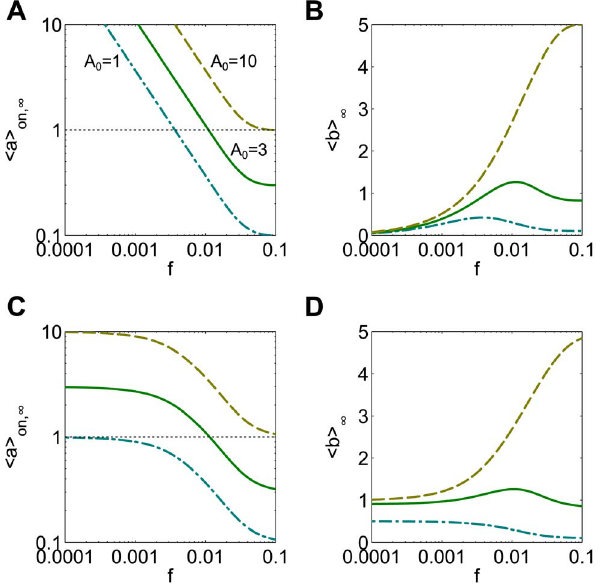
Figure 8. Input signal dose can affect whether a bell-shaped response is observed. The production rate function is F(a)=a 2 / (a 2 + K 2 ) with K=1. ( A ) Amplitude compensated signals with A 0 =10 (tan dashed curve) leads to , a . on, ‘ that is larger than K (i.e. above the horizontal dotted line) for all possible frequencies, while any choice of A 0 smaller than 10 allows , a . on, ‘ to cross K (teal dash-dotted curves and green solid curves). ( B ) When A 0 =10, all values of , a . on, ‘ are in the sublinear, saturating part of the sigmoidal F, and a strictly increasing response in , b . ‘ is observed. When the mean input dose is lower, bell shaped responses are observed, with the peak frequency correspond- ing to the frequency at which , a . on, ‘ =K. ( C ) Duration compensated signals may lead to responses of , a . on, ‘ that are strictly below K, cross K at some frequency, or are strictly above K (teal dash-dotted curves, green solid curves, and tan dashed curves, respectively). ( D ) The frequency responses of , b . ‘ are strictly decreasing (teal), bell-shaped (green), and strictly increasing (tan), respectively. For each A 0 used, d